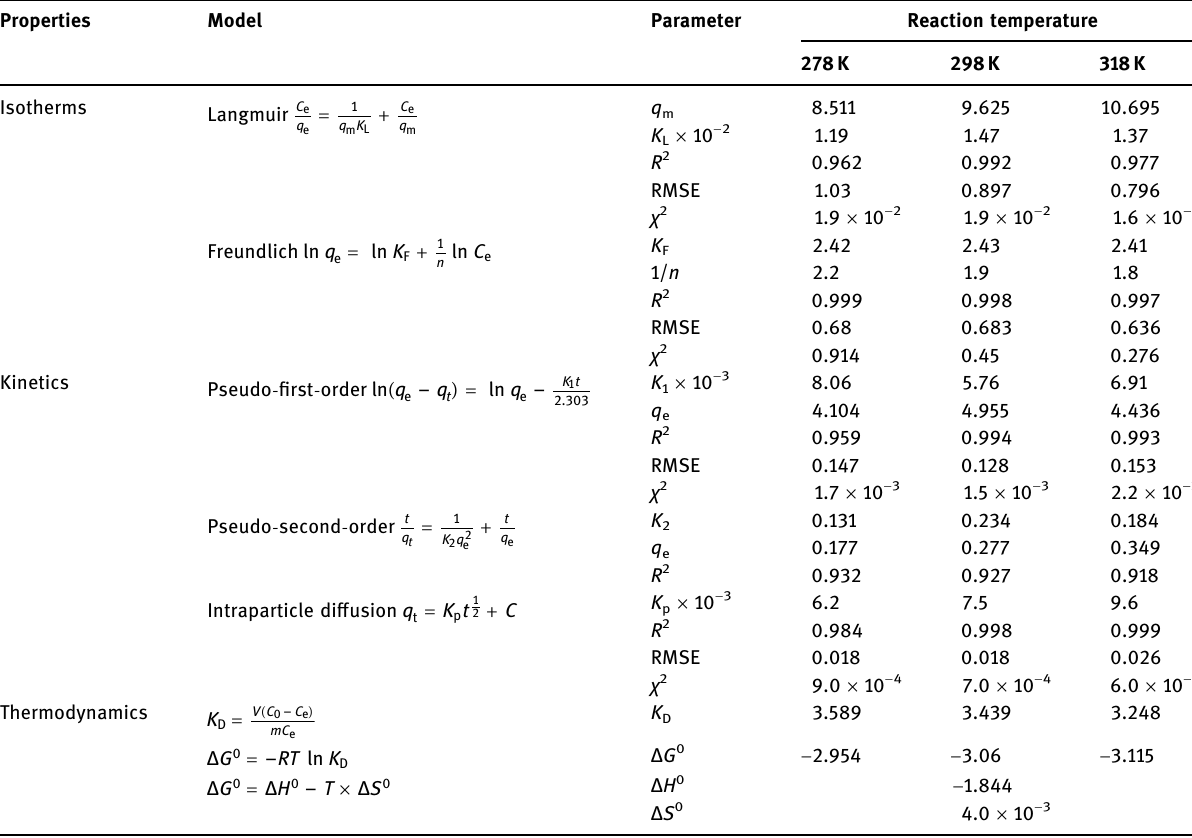
Table 2: Adsorption isotherm, kinetic, and thermodynamic parameters for ARG dye removal by porous ceramsite at di ff erent reaction temperatures Properties